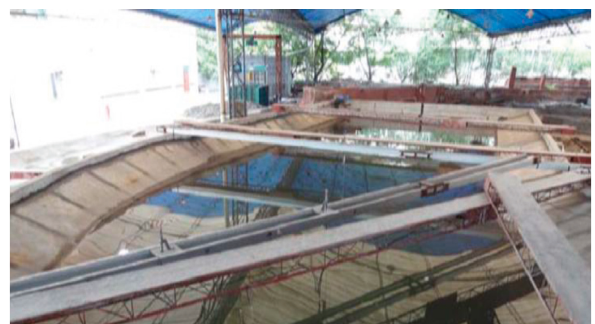
Figure 2: Layout of channel model.